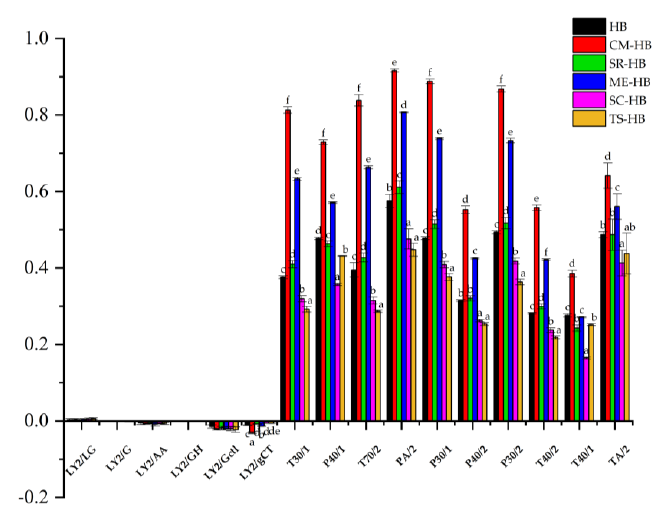
Figure 1. E-nose response value plot for original and fermented highland barley samples: HB (original highland barley), CM-HB (fermented highland barley with C. militaris ), SR-HB (fermented highland barley with S. rugoso-annulata ), ME-HB (fermented highland barley with M. esculenta ), SC-HB (fermented highland barley with S. commune ), TS-HB (fermented highland barley with T. sanguinea ). Different superscript lowercase letters in a row (a–f) represent statistically significant differences between the mean values at p < 0.05 determined by one-way ANOVA. The response values (0~0.2) of the first six sensors (LY2/LG, LY2/G, LY2/AA,